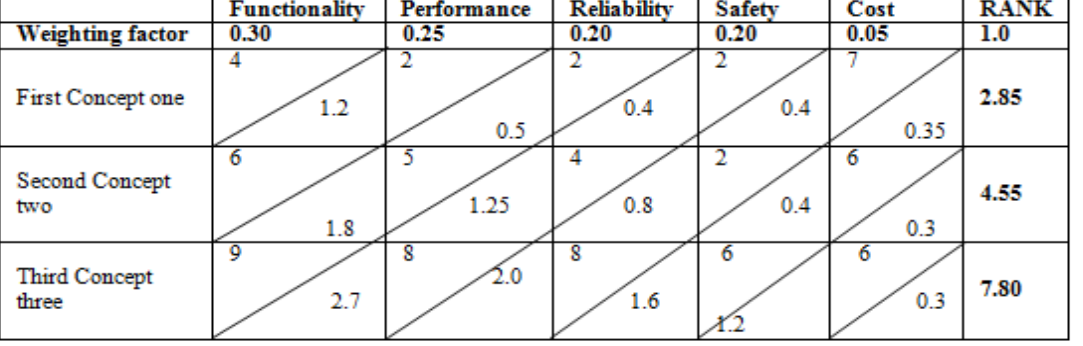
Table 2. Decision